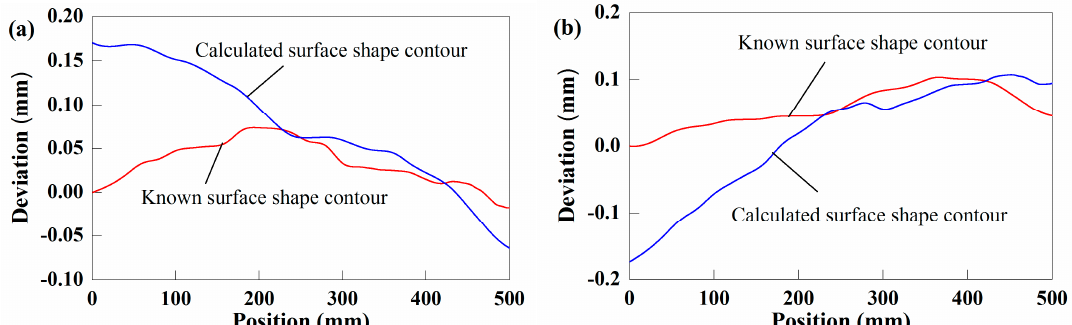
Figure 25. Comparison between the calculated surface shape contour and known surface shape contour: ( a ) PB is the measured surface. ( b ) PA is the measured surface.